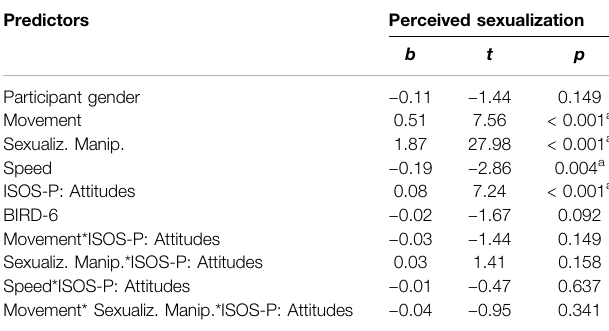
TABLE 6 | Mixed linear model for predicting perceived sexualization by conditions and attitudes favorable to sexual objecti fi cation.